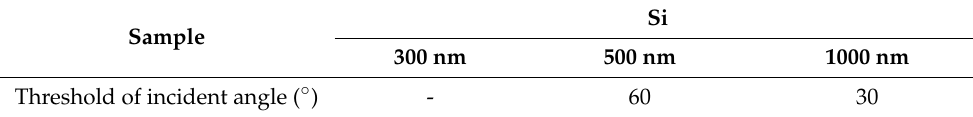
Table 1. Incident angle thresholds affected by the shadow effect on the Si